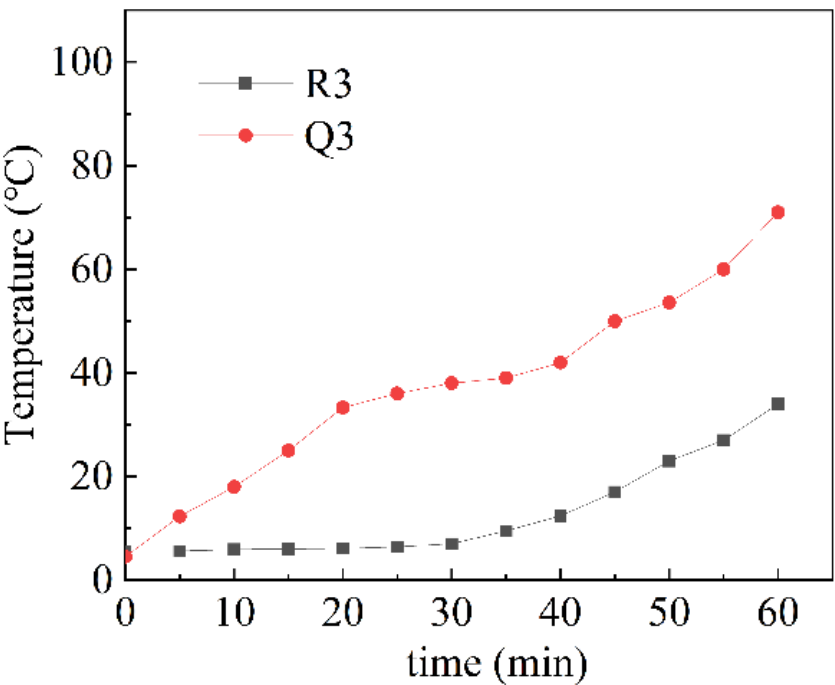
Figure 13. T-t curves of measurement point R3 and Q3 at the center of the wall panel.